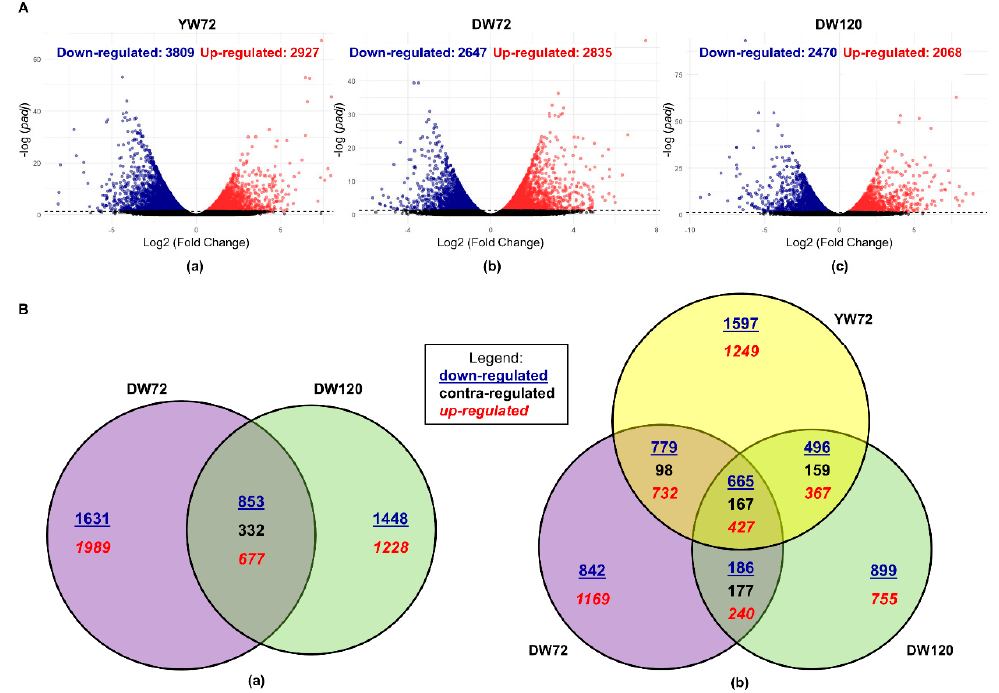
Figure 2. Differentially expressed genes (DEGs) under waterlogging: ( A ) Volcano plot illustrating number of DEGs between flooded and control treatments of Yerong at 72 h ( a ), and Deder2 at 72 h ( b ) and 120 h ( c ). ( B ) Venn diagram illustrating unique and common DEGs in barley roots: ( a ) number of DEGs in Deder2 at 72 and 120 h of waterlogging stress; ( b ) number of unique and shared DEGs between Yerong at 72 h, and Deder2 at 72 and 120 h post waterlogging treatment. YW72, Yerong 72 h of waterlogging; DW72, Deder2 72 h waterlogging; DW120, Deder2 120 h waterlogging.